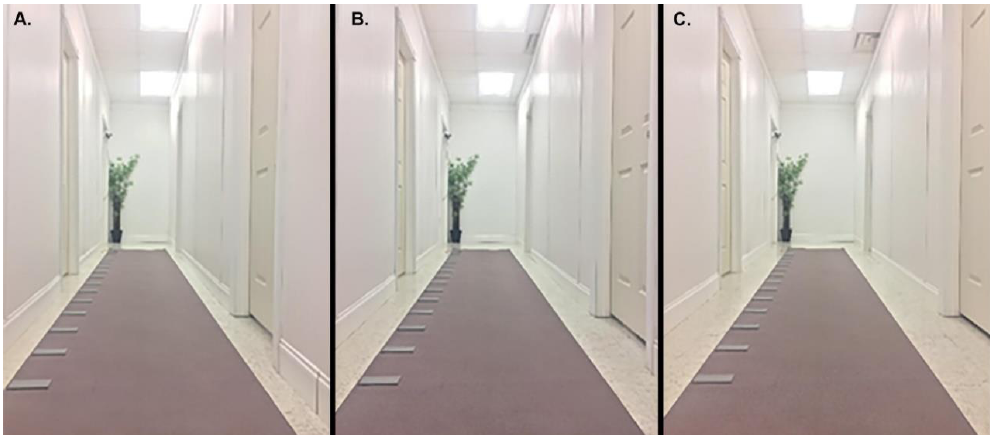
Figure 1. Hallway width conditions. The right wall was positioned in one of three experimental conditions: (A) narrow, (B) medium, or (C) wide, where the distance from the left wall to the right wall was 1.14 m, 1.31 m, or 1.48 m, respectively. The GAITRite mat was repositioned for each condition to maintain a centralized position.